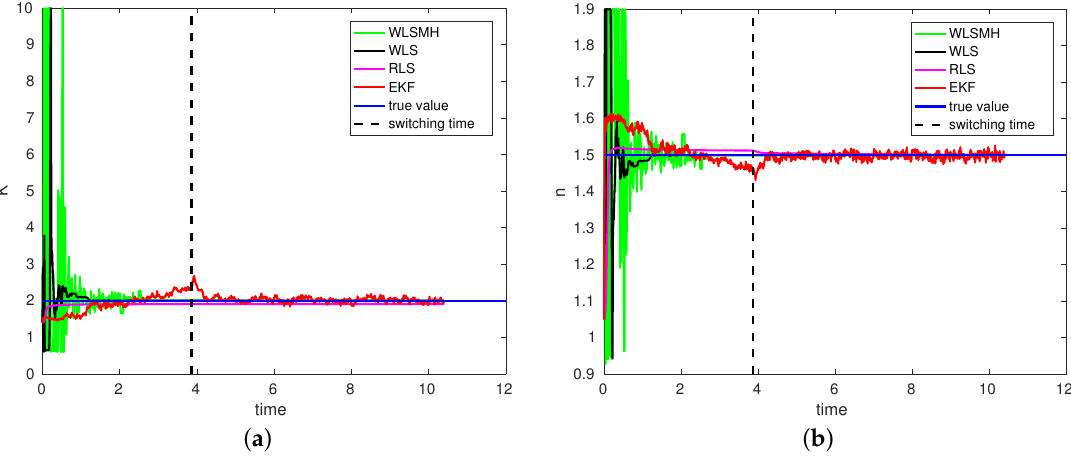
Figure 3. Estimation of the fouling parameters K , n for the three chosen cases together with the optimal switching time. ( a ) Estimation of the fouling parameter K ; ( b ) estimation of the fouling parameter n .